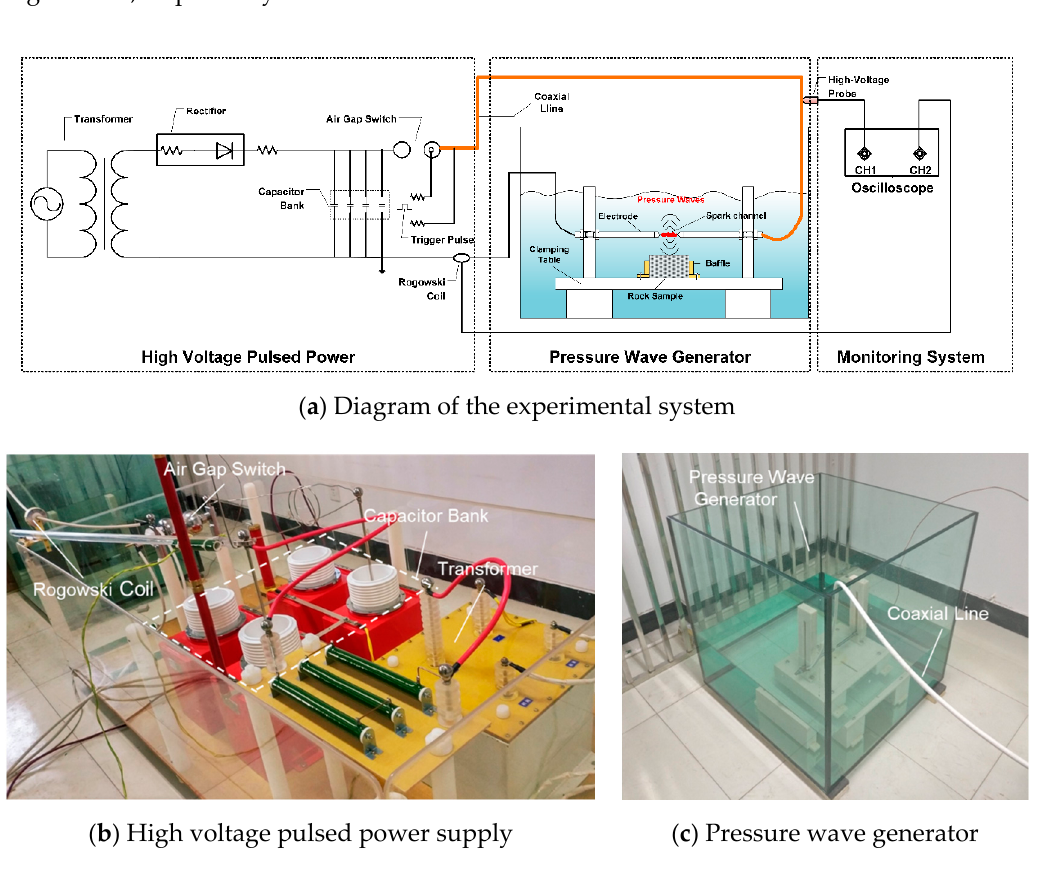
Figure 2. Two types of concrete sample.